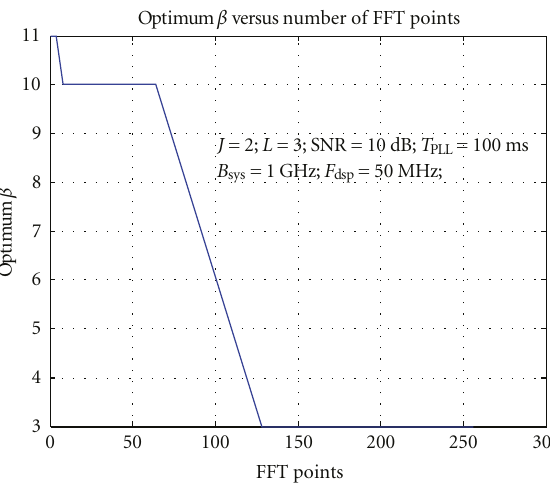
Figure 6: Optimal α versus SNR of received signal.